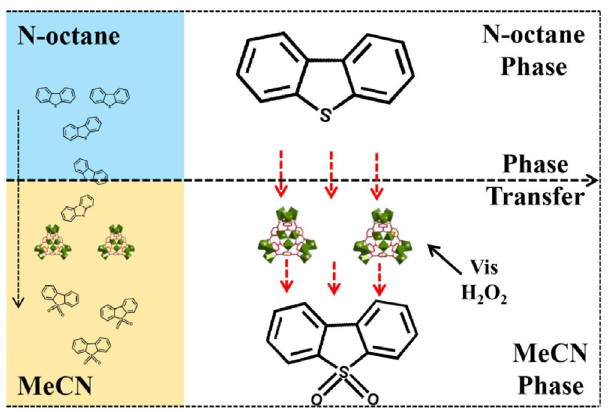
Figure 12. Extraction–photooxidation technology using acetonitrile as a solvent. Reproduced from ref. [114] with permission from Elsevier. Copyright 2021 Elsevier.